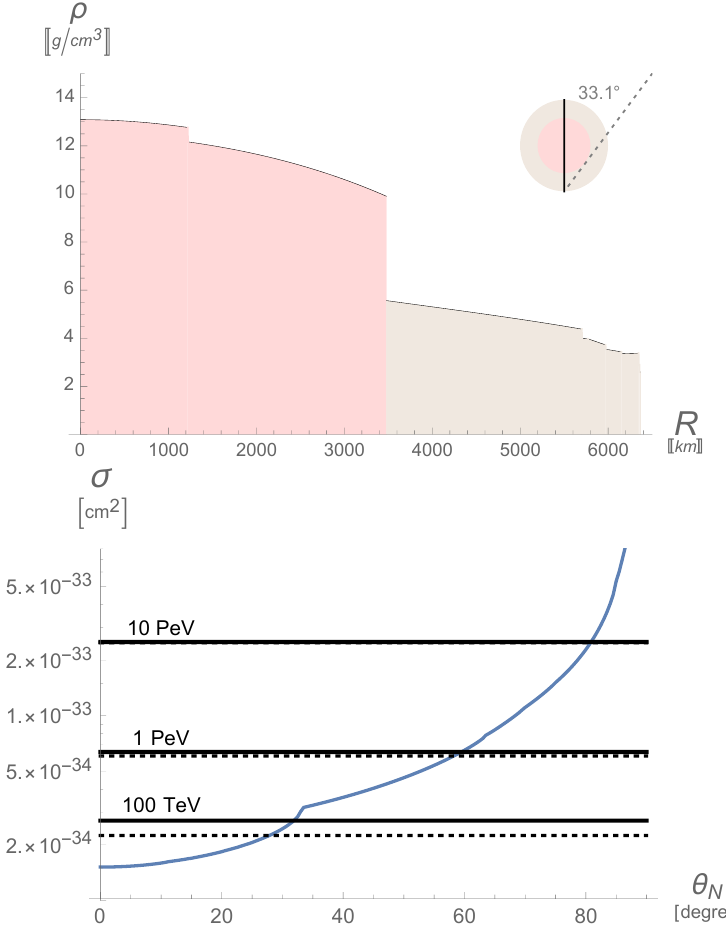
Figure 3. Top panel: Earth’s density in g/cm 3 according to the PREM model [51]; note the discontinuity between the mantle (brown area) and the core (red area) at a distance from the center of R = arcsin ( R km. The limiting angle θ / R ⊕ ) = 33.1 ◦ is emphasized. Bottom panel; three values of N , core core the neutrino (continuous lines) and antineutrino (dotted lines) cross sections, as compared with the ) related to e-folding absorption, as defined in the critical value of the cross section σ (cid:63) ( θ N